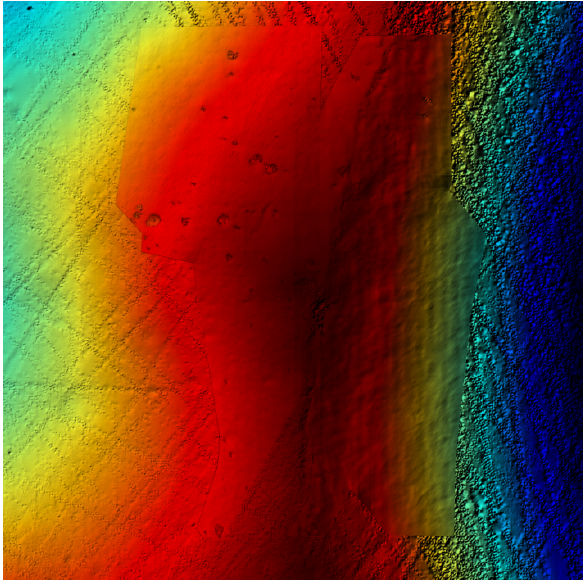
Figure 5. Mosaicked DTM blended into LOLA data in a colorized shaded relief